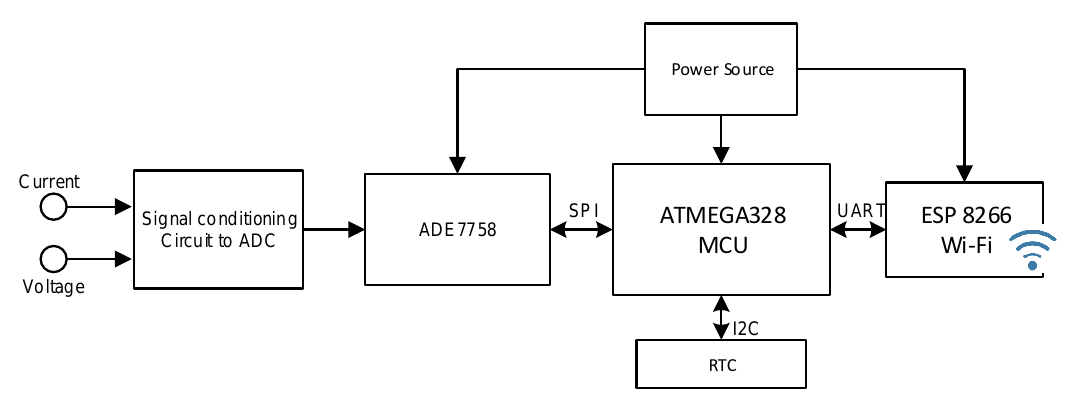
Figure 2. Interfacing block diagram for the IoT PQ sensor prototype.